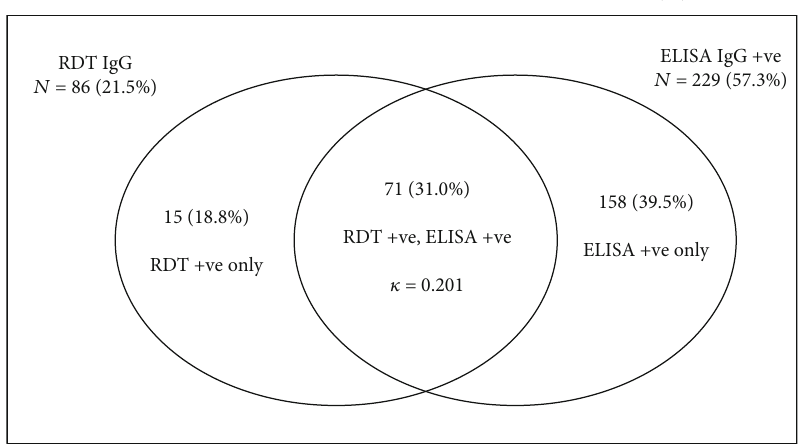
Figure 2: Seroprevalence of Toxoplasma gondii antibodies (IgG) among the study participants. The number of IgG-positive cases based on RDT was compared with ELISA using kappa statistics.